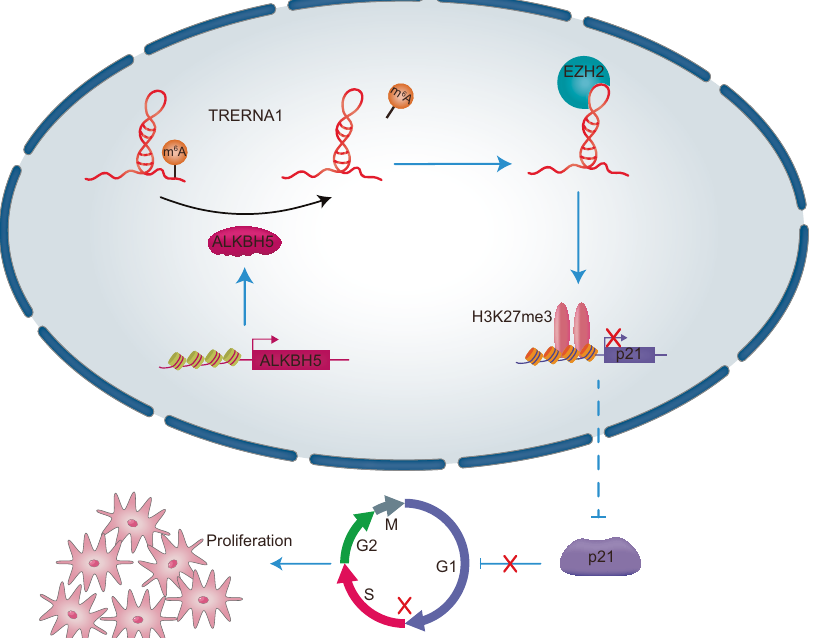
Fig. 7 A schematic diagram of lncRNA TRERNA1 functions in DLBCL. ALKBH5-mediated upregulation of TRERNA1 with a low level of m 6 A modi fi cation can promote cell proliferation and cell cycle progression. The m 6 A modi fi cation of TRERNA1 was shown to epigenetically silence p21 transcription to accelerate cell cycle progression by interacting with